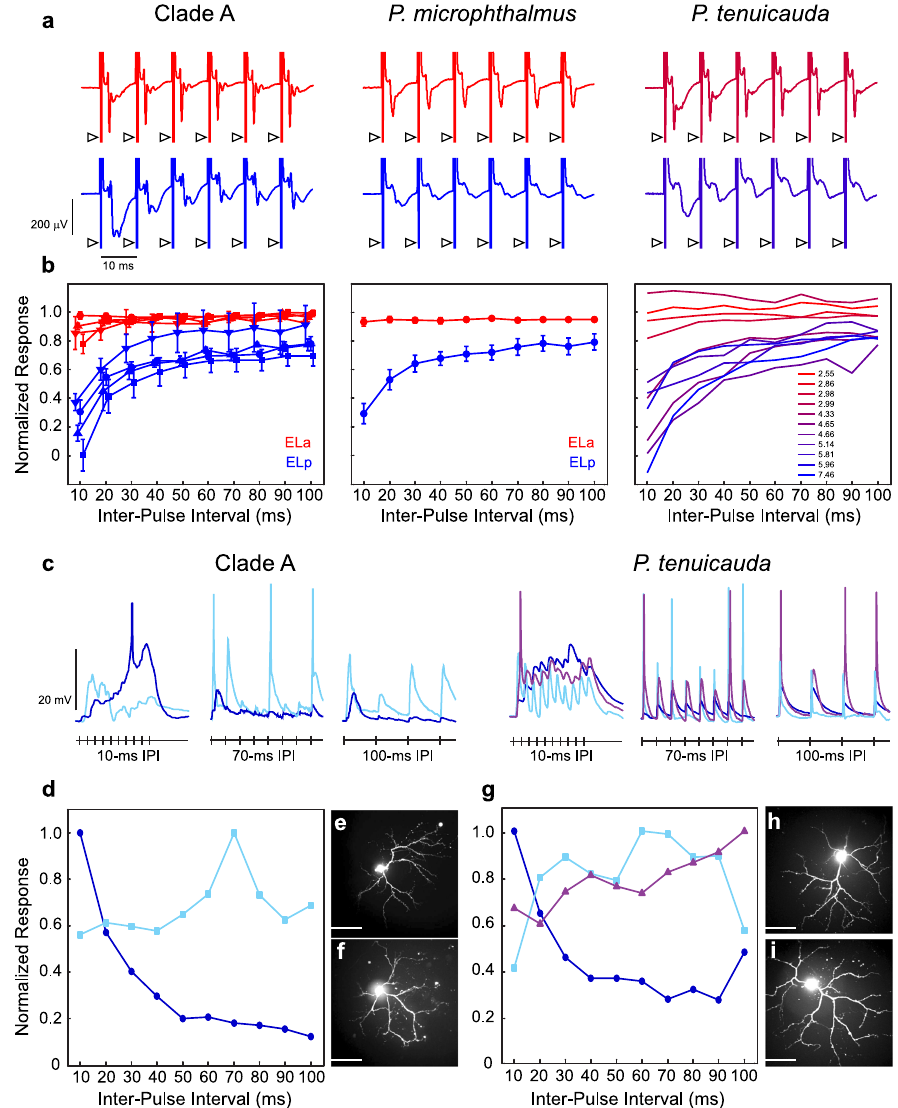
Figure 5. Inter-pulse interval processing arises in ELp of clade-A species and P . microphthalmus , and in the posterior end of EL in P . tenuicauda . ( a ) Representative mean evoked potentials (n = 10 traces) from ELa (red) and ELp (blue) of clade A (left) and P . microphthalmus (center), and towards the anterior (top) and posterior (bottom) ends of EL in P . tenuicauda (right), obtained in vivo in response to electrosensory pulse trains with inter- pulse intervals of 10ms. Arrowheads denote stimulus artefacts. ( b ) We averaged the peak-to-peak amplitude of the evoked potential in response to the second through tenth pulses of the stimulus and normalized it to the peak- to-peak amplitude of the evoked potential in response to the first pulse of the stimulus (see Methods). For clade A (left) and P . microphthalmus (center), we normalized responses separately for ELa (red symbols) and ELp (blue symbols) and figure symbols represent the mean normalized amplitude and the error bars represent the SEM. The amplitude of evoked potentials attenuates at short IPIs in ELp, but not ELa, of clade-A species ( B . brachyistius : squares, n = 6, F 9,95 = 4.29, p < 0.001; B . niger : triangles, n = 4, F 9,57 = 11.29, p < 0.0001; P . adspersus : circles, n = 3, F 9,38 = 11.93, p < 0.0001; G . petersii : inverted triangles, n = 3, F 9,38 = 2.00, p = 0.06) and P . microphthalmus (n = 6, F 9,95 = 10.80, p < 0.0001). In EL of P . tenuicauda , evoked potentials attenuate towards the posterior end of EL, but not towards the anterior end. For P . tenuicauda , the color code represents the latency (in ms) to the first negative peak of the evoked potential in response to a 0.5-ms bipolar square pulse, from the shortest latency in red to the longest in blue. These latencies span those previously reported in ELa and ELp of clade-A species (ELa: 3.7 ms, ELp: 8.2 ms) and P . microphthalmus (ELa: 2.8 ms, ELp: 7.4 ms) 21 . ( c ) Representative response traces of neurons sensitive to inter-pulse intervals in ELp of B . niger (left) and the posterior end of EL in P . tenuicauda (right). In vitro whole-cell recordings were obtained in response to electrical stimulation of the lateral lemniscus. Traces depict responses to pulse trains with IPIs of 10ms, 70 ms, and 100 ms. Based on the tuning curves ( d , g , see Methods), neurons were classified as high-pass (dark blue), band-pass (light blue), and low-pass (purple). Neurons sensitive to IPIs in B . niger ( e , f ) and P . tenuicauda ( h , i ) are morphologically similar and highly dendritic, as evidenced by confocal fluorescence imaging (see Methods). Scale bars in photomicrographs represent 50 µ